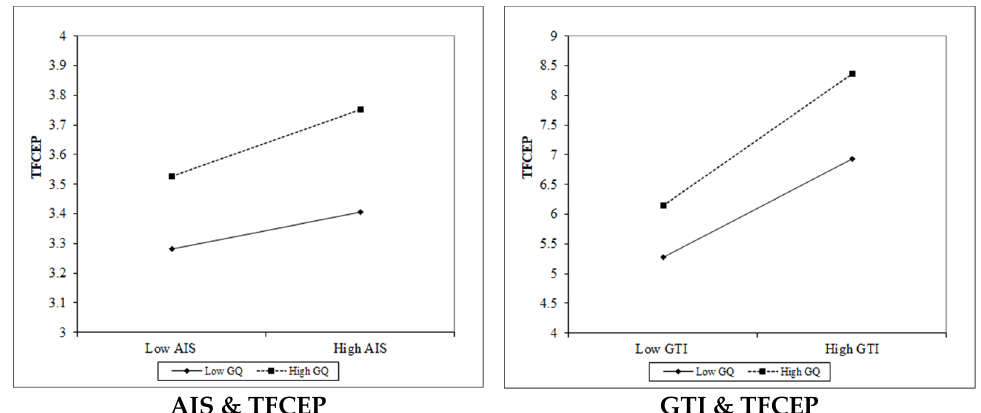
Figure 2. The moderating effect of government quality.